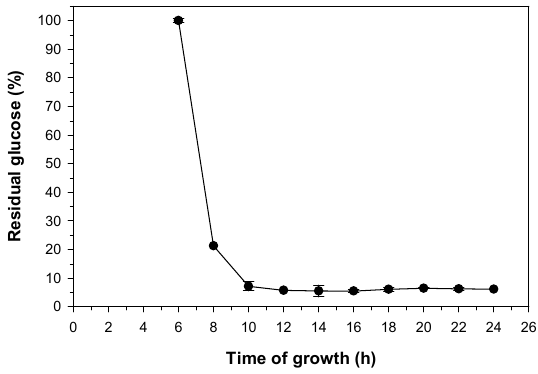
Figure 1. Effect of the growth time of Pichia pastoris on the elimination of D -glucose. Experimental conditions: 1 g/L D -glucose, 1 g/L D -galactose, 10 min, 30 °C.